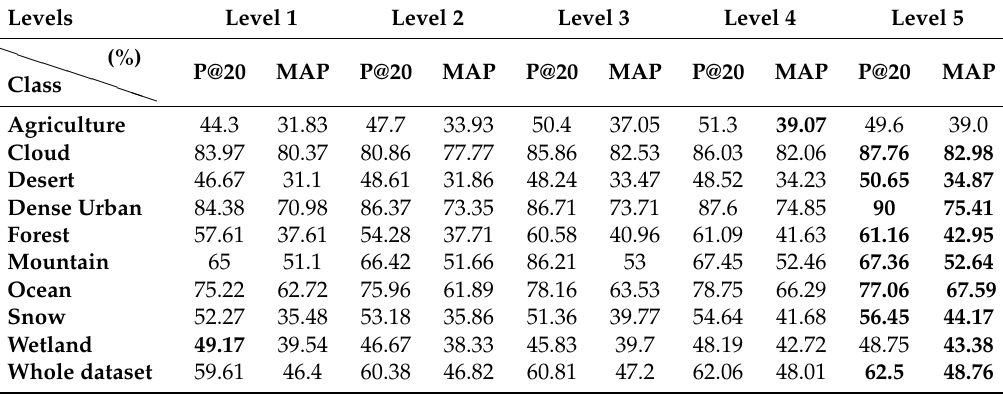
Table 1. Retrieval results for different sampling levels of Spectral Sensitivity Functions (SSFs) according to the better spectral sensitivity function for each category from the ICONES-Hyperspectral Satellite Imaging (HSI)